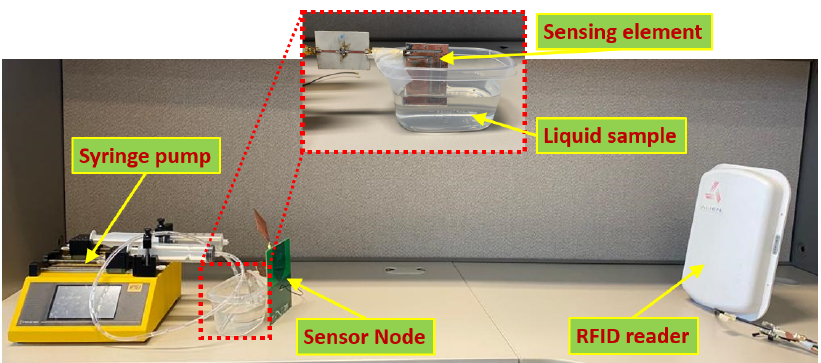
Figure 4. Experimental setup for wireless liquid level measurement.